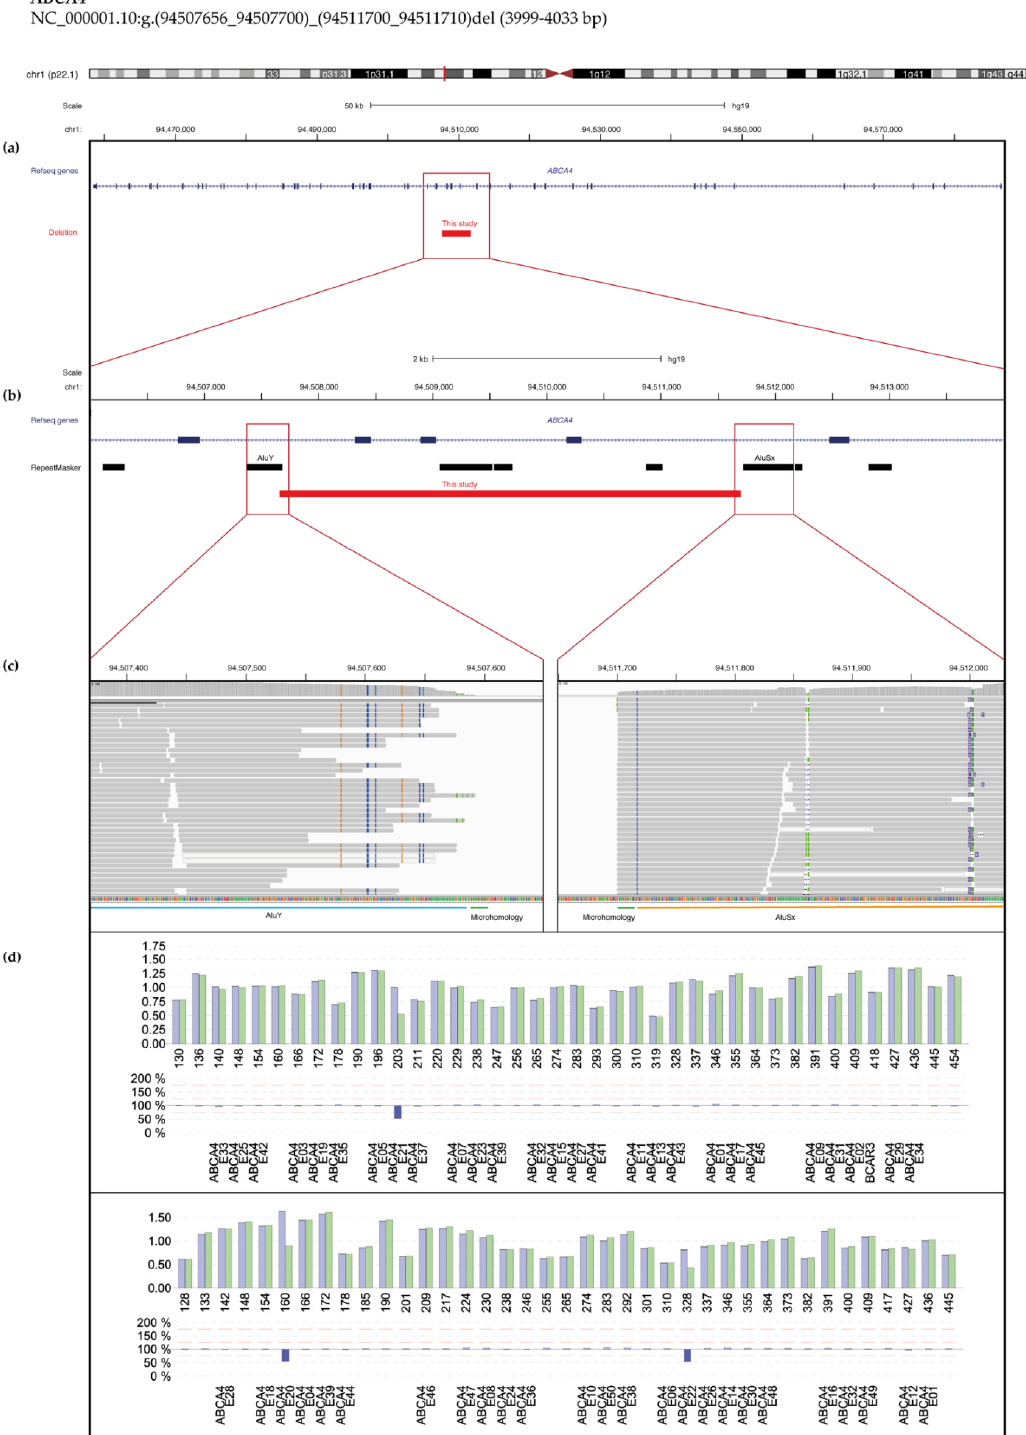
Figure A1. ABCA4 chr1:g.(94507656_94507700)_(94511700_94511710)del (3999–4033 bp), heterozygous. ( a ) Chromosomal overview and zoom into the ABCA4 locus. The red bar highlights the location and size of the deletion. ( b ) Magnification